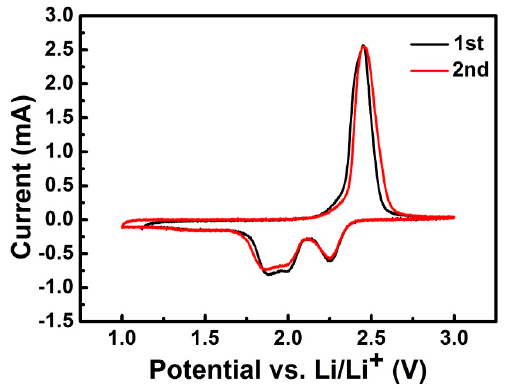
Figure 7. CV profiles of lithium sulfur batteries with the S/GO composite powders (scan rate of 0.1 mV s − 1 ).